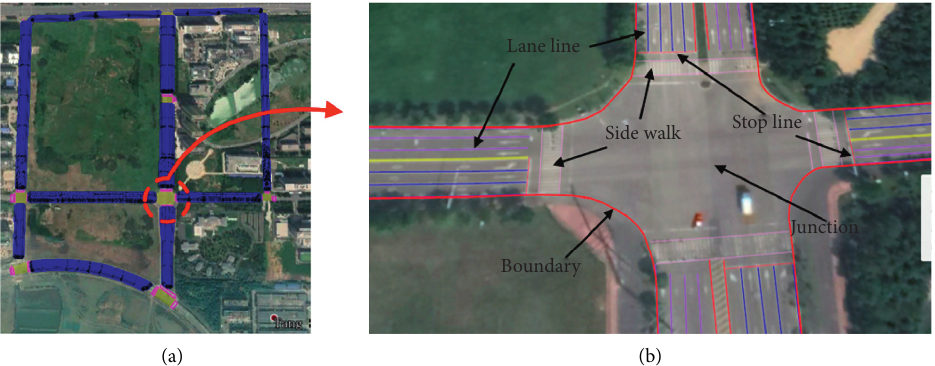
Figure 18: Testing roadway layout: (a) the high-resolution map of the experimental roadway; (b) an enlarged view of the map data.